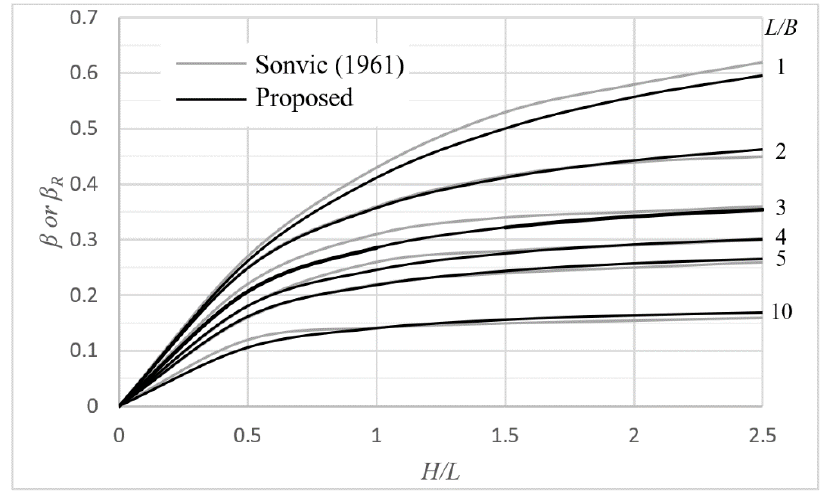
Figure 3. Comparison chart between Sovinc’s [8] β factor for rigid rectangular footing and the proposed ; all curves refer to ν = 0.5.